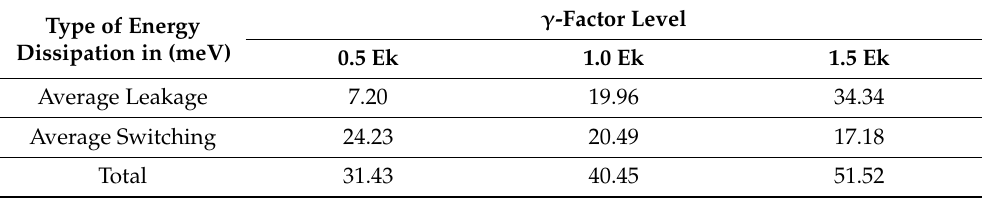
Table 3. Values of energy dissipation for proposed DFF design at different γ -factor